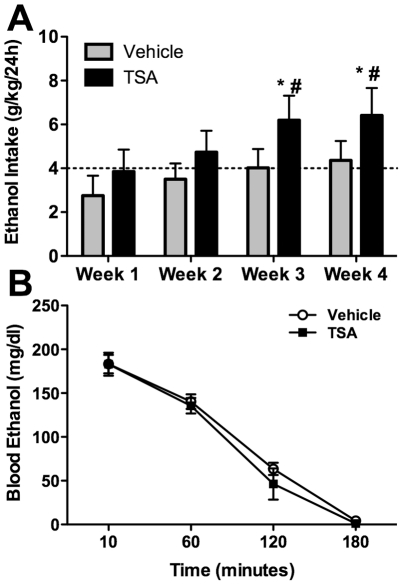
Histone deacetylase activity inhibition increases ethanol intake.
A. Average weekly ethanol intake of C57BL/6NCrl mice after i.p. treatment with 2 mg/kg trichostatin A (TSA) or vehicle (n = 9) for 5 days. Both groups had identical baseline average ethanol intake (dotted line) prior to treatment with TSA. TSA caused ethanol intake to increase significantly by weeks 3–4 post-treatment (*p<0.001 vs. baseline; #p<0.02 vs. vehicle at same time points). B. Blood ethanol concentration in TSA and vehicle treated mice following a 2-mg/kg ethanol injection (i.p.).